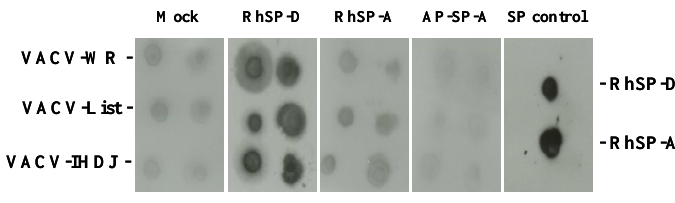
Figure 1. Binding of surfactant proteins to Vaccinia virus (VACV). Three VACV strains, VACV-WR, VACV-Lister and VACV-IHD-J, were dotted onto membranes and incubated with 2 µg of various surfactant proteins. After extensive washes, bound SPs were detected with specific anti-surfactant protein antibodies and revealed by